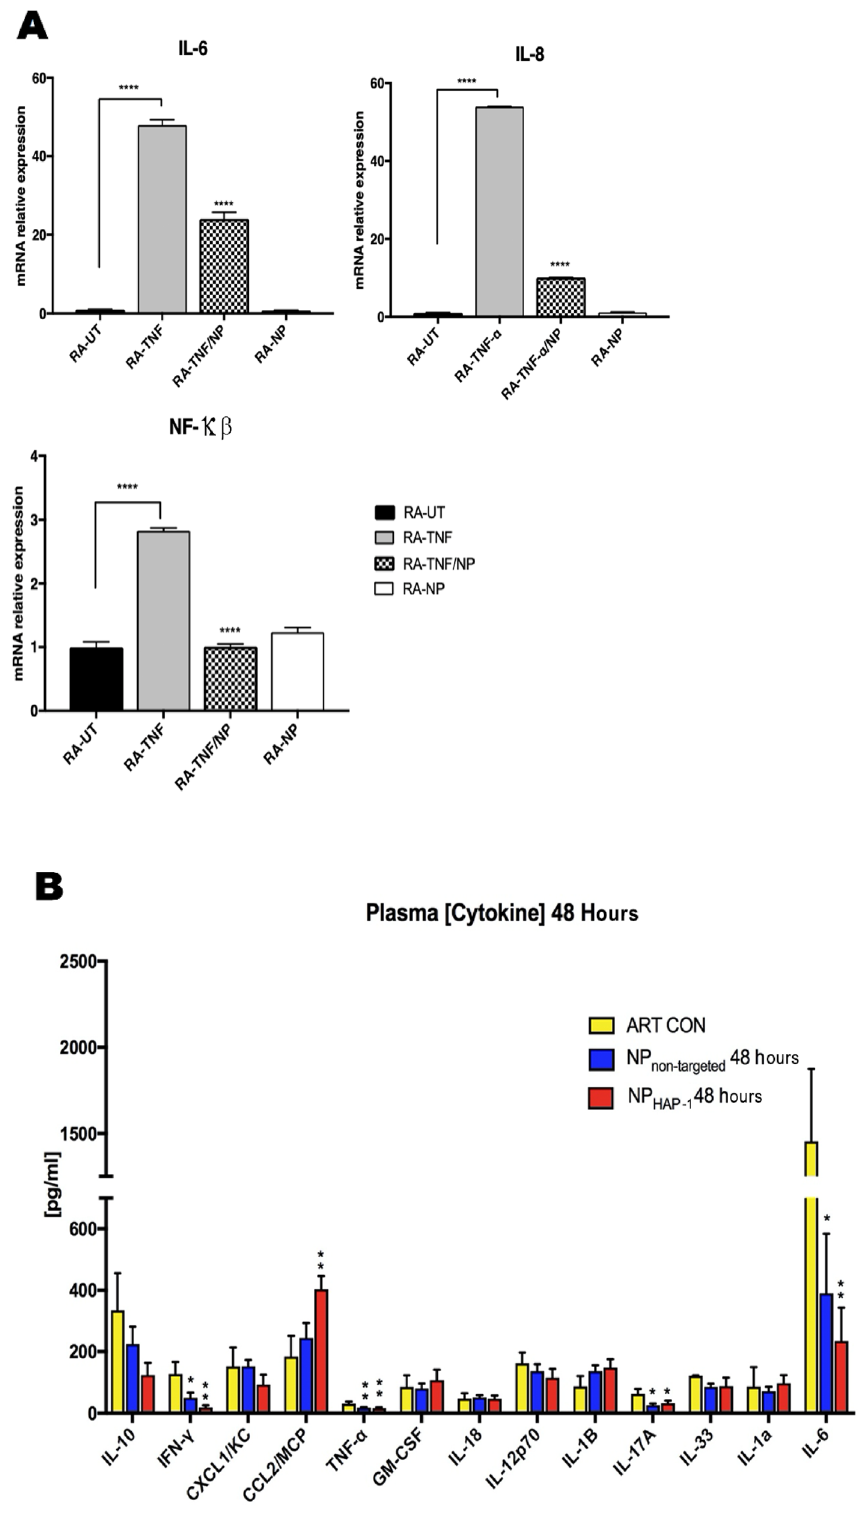
Figure 5. NP effect on cytokine production. ( A ) In vitro effects showing NP suppresses pro-inflammatory upregulation of NF-κβ, IL-6 and IL-8 mRNA in RA-FLS cells. Cultured RA-FLS were stimulated with TNF-α alone (25 ng/mL) or TNF-α plus NP (30 µg/mL) for 24 h. Expression levels of mRNA were assayed by quantitative real-time RT-PCR. The mRNA levels of each gene were standardized against GAPDH levels. Data are expressed as the mean (S.D.) (n = 4). *p < 0.05; **p < 0.01, ***p < 0.001, ****p < 0.0001 vs TNF-α alone. NP significantly inhibited TNF-α stimulated production of IL-6, IL- 8 and NF-κβ. ( B ) In vivo cytokine effects of NP in an arthritis model of inflammation. Plasma concentrations of cytokines in non-treated (ART CON), NP non-targeted and NP HAP-1 treated arthritic rats were measured. Arthritic rats were treated with NP intravenously administered once daily, for two days and blood collected 48 h after the initial injection. Low plasma concentrations of pro- inflammatory cytokines IFN-γ, IL-6 and IL-17A were observed in both the NP non-targeted and NP HAP-1 treated rats. Data expressed as the mean + S.D. (n = 6). *p < 0.05; **p < 0.01 against